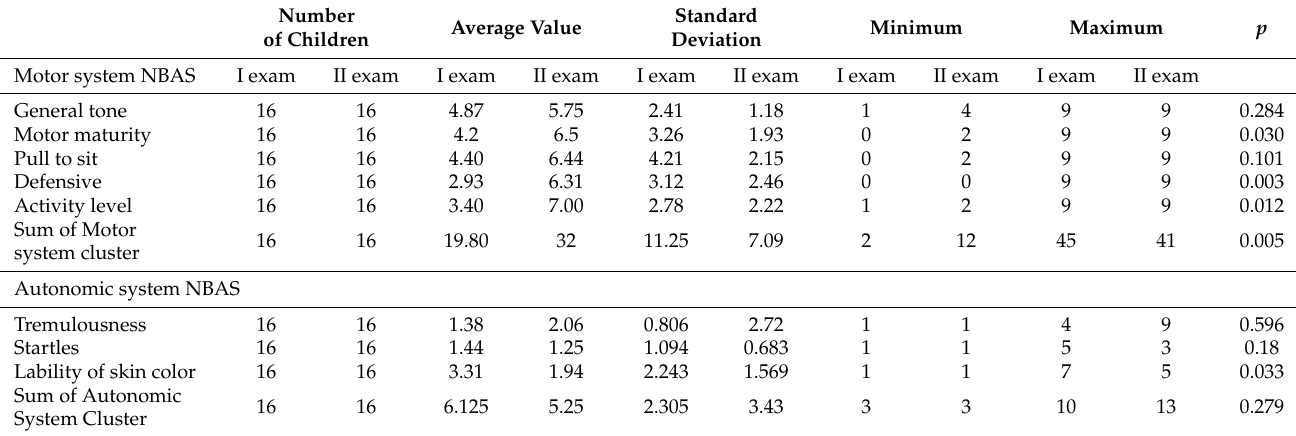
Table 2. Comparison of the first and second examination.